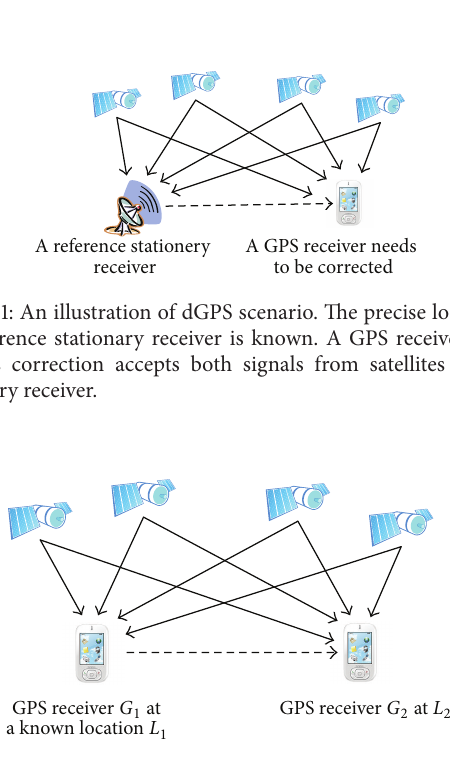
Figure 2: A consumer-grade GPS receiver at a location which has exact known